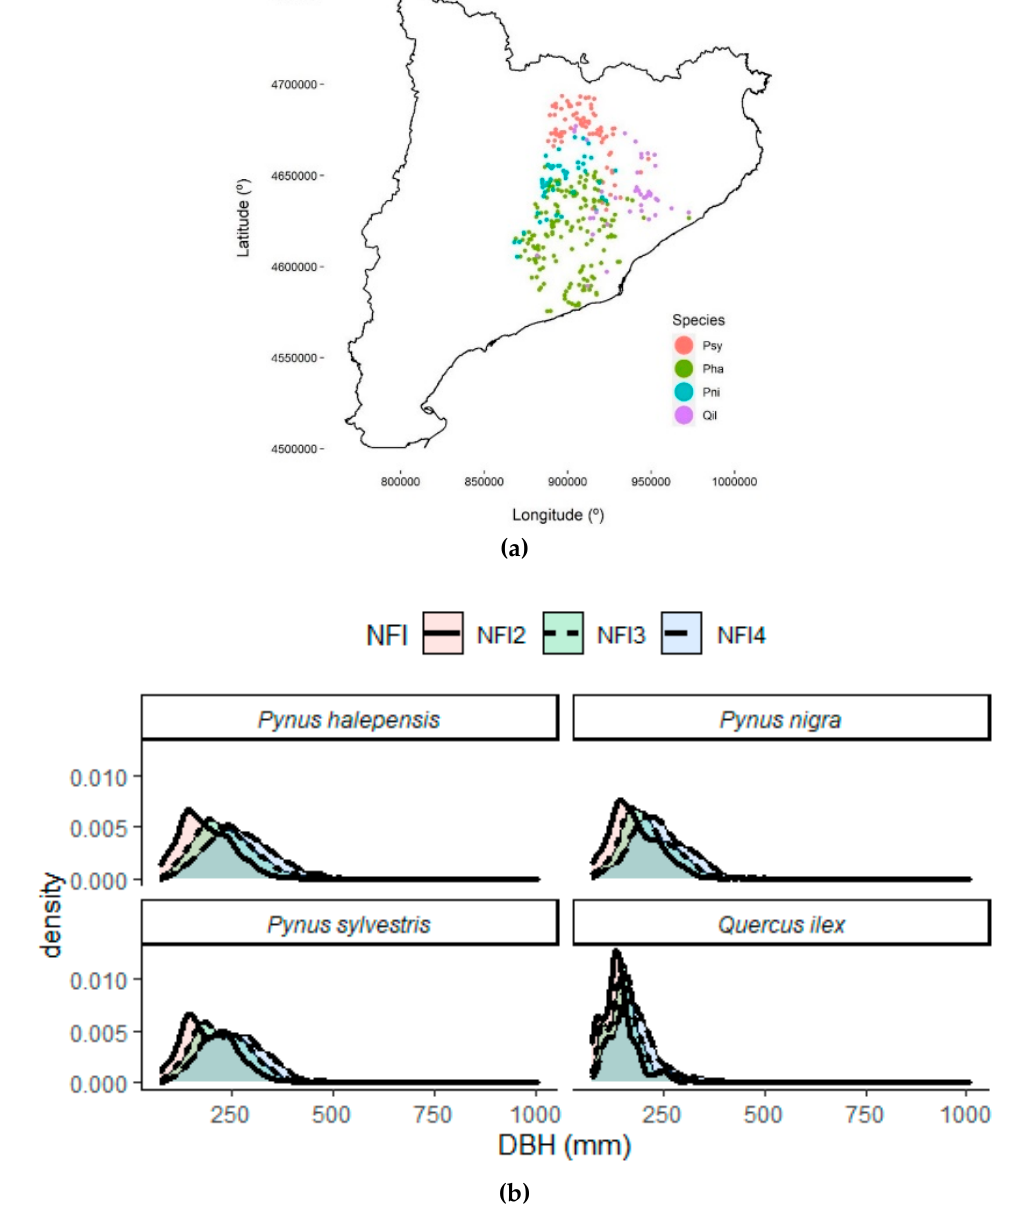
Figure 1. ( a ) Distribution of the National Forest Inventory plots used in this study, as monospecific plots of Pinus sylvestris (Psy), Pinus halepensis (Pha), Pinus nigra (Pni), and Quercus ilex (Qil) distributed in the Barcelona region of Catalonia; ( b ) diameter distribution (DBH, mm) for each species at the second, third, and fourth National Forest Inventory (NFI2, NFI3, and NFI4).